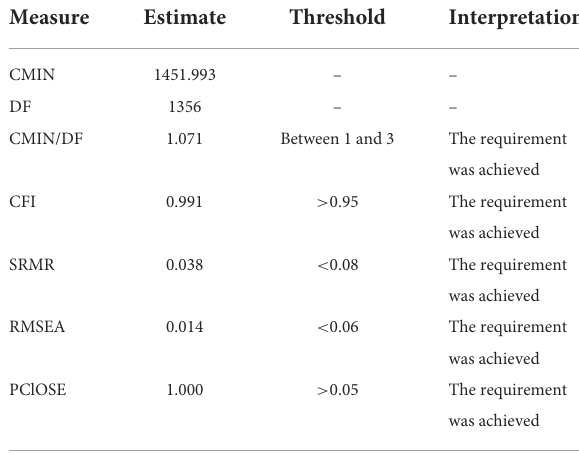
TABLE 1 Reliabilities of instruments. TABLE 2 Model fit measures of latent